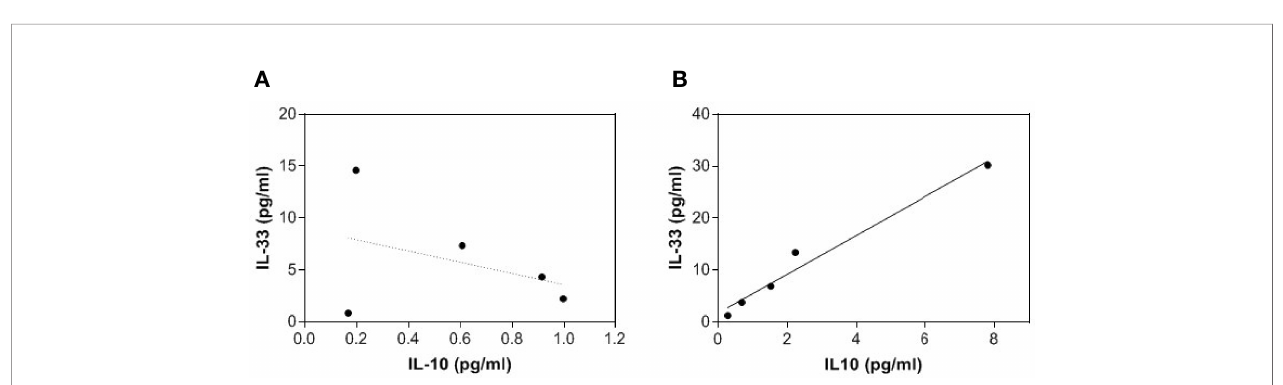
FIGURE 2 | Correlation between IL-33 and IL-10 serum levels. The relationships between IL-33 and IL-10 serum levels both at baseline (A) and after 12-month homotaurine treatment (B) are reported in the scatterplots, with lines representing linear